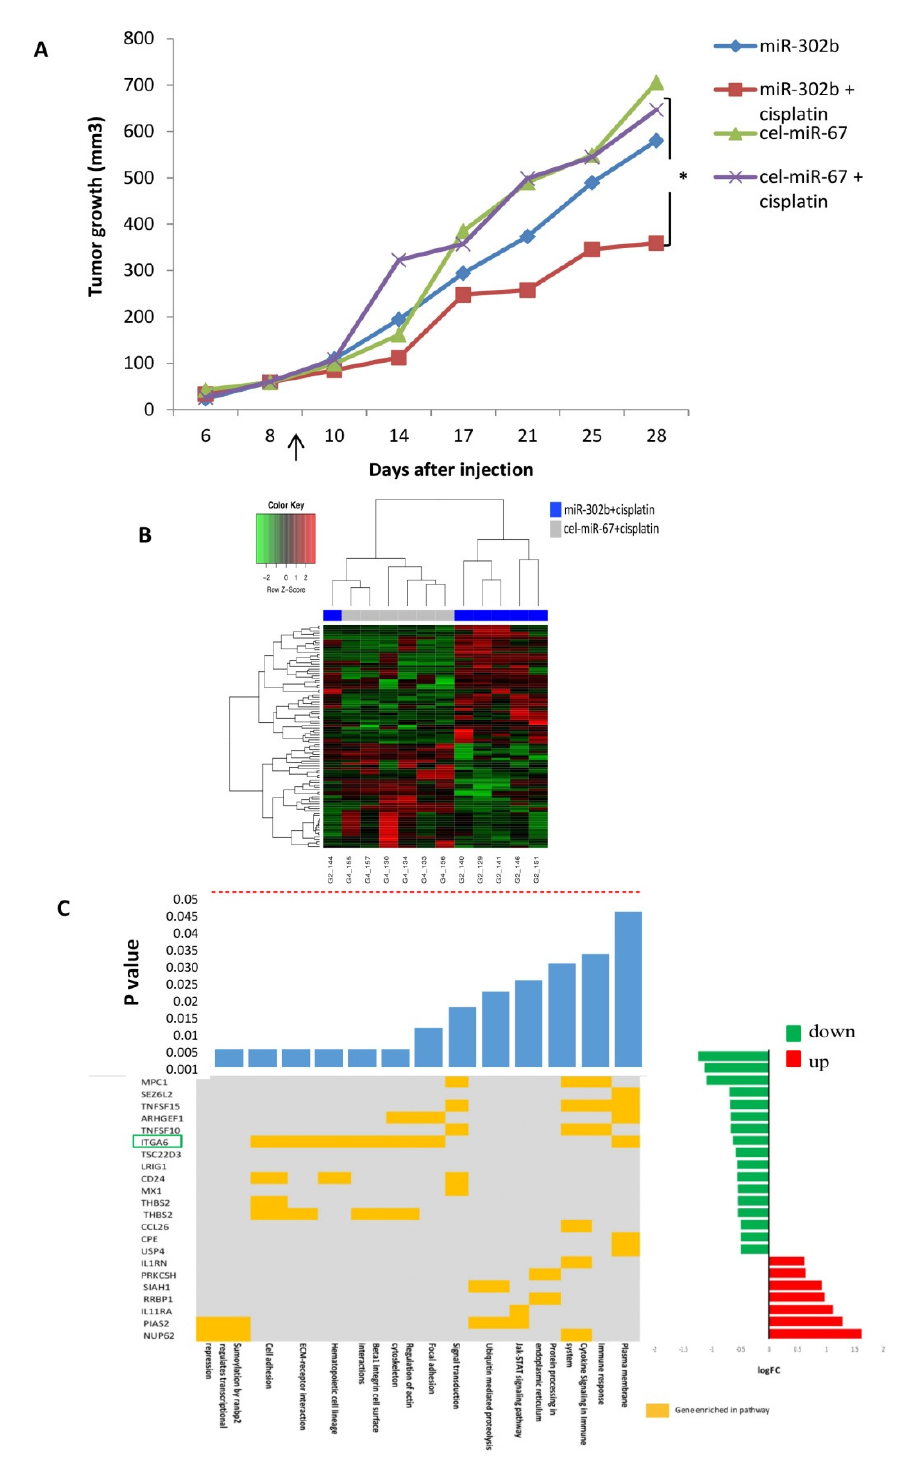
Figure 1. Effects of miR ‐ 302b and cisplatin treatment in an orthotopic murine triple ‐ negative breast cancer (TNBC) model and transcriptional landscape established by miR ‐ 302b and cisplatin treatment in an in vivo assay. ( A ) Tumor volumes in Severe Combined Immunodeficient (SCID) mice after the peritumoral injection of miR ‐ 302b or miR ‐ cel ‐ 67 control plus cisplatin or saline treatment evaluated across different time points. Data presented are mean values ( n = 7; * p ≤ 0.05 Student’s t ‐ test). Arrow indicates start of treatment. ( B ) Heatmap showing the differentially expressed genes (log fold change > 0.5 and p ≤ 0.05) in mice tumors treated with miR ‐ 302b mimic